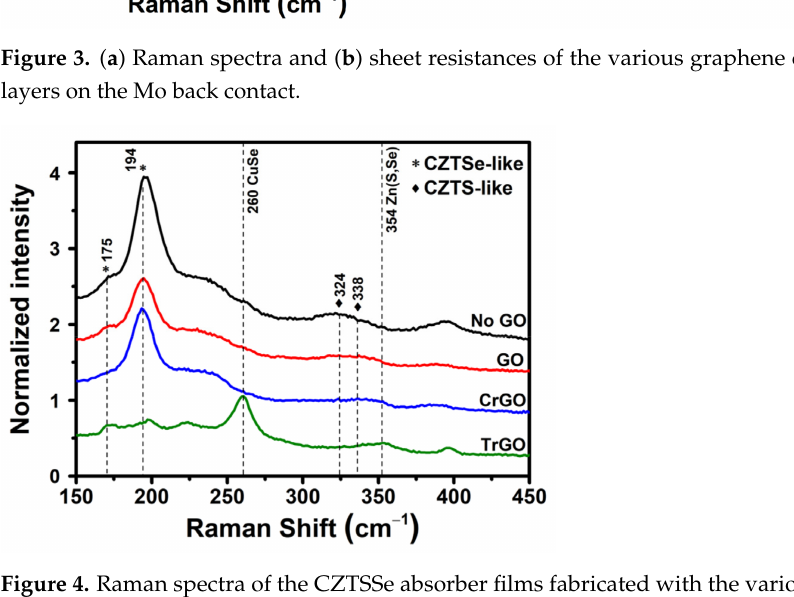
Figure 4. Raman spectra of the CZTSSe absorber films fabricated with the various graphene oxide intermediate layers. Table 1. Elemental composition and compositional ratios of the CZTSSe absorber films fabricated with the various graphene oxide intermediate